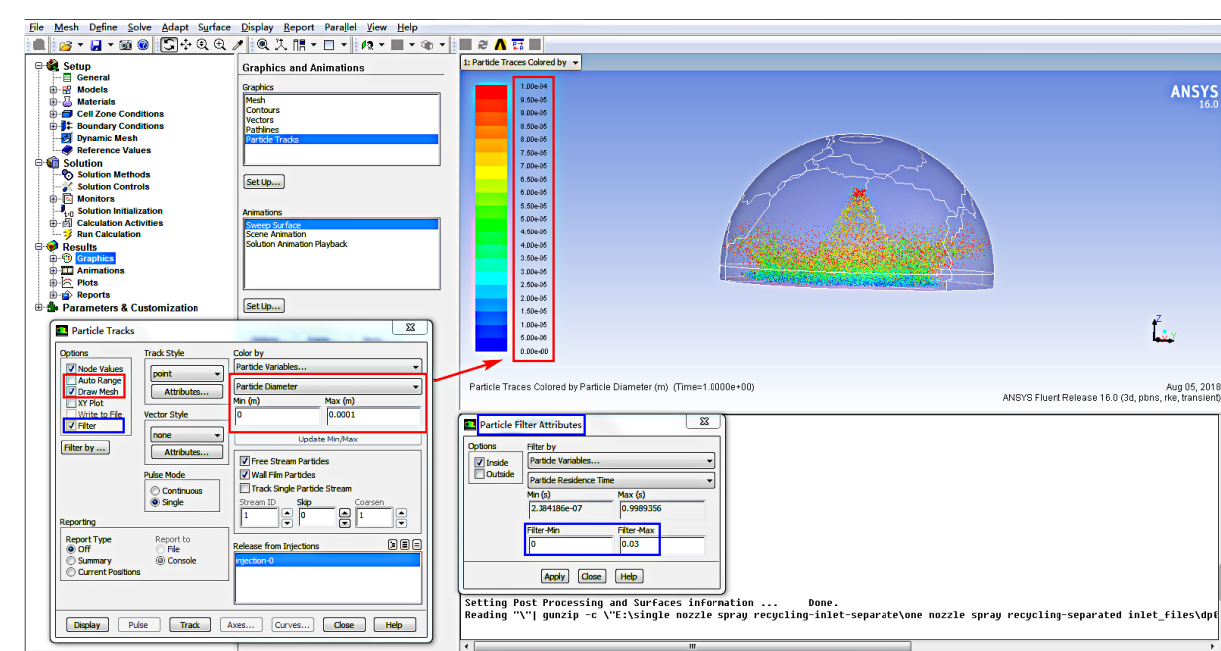
Figure 13. Display setting of particle diameter distribution of paint mist within 0~0.03 s of retention time.